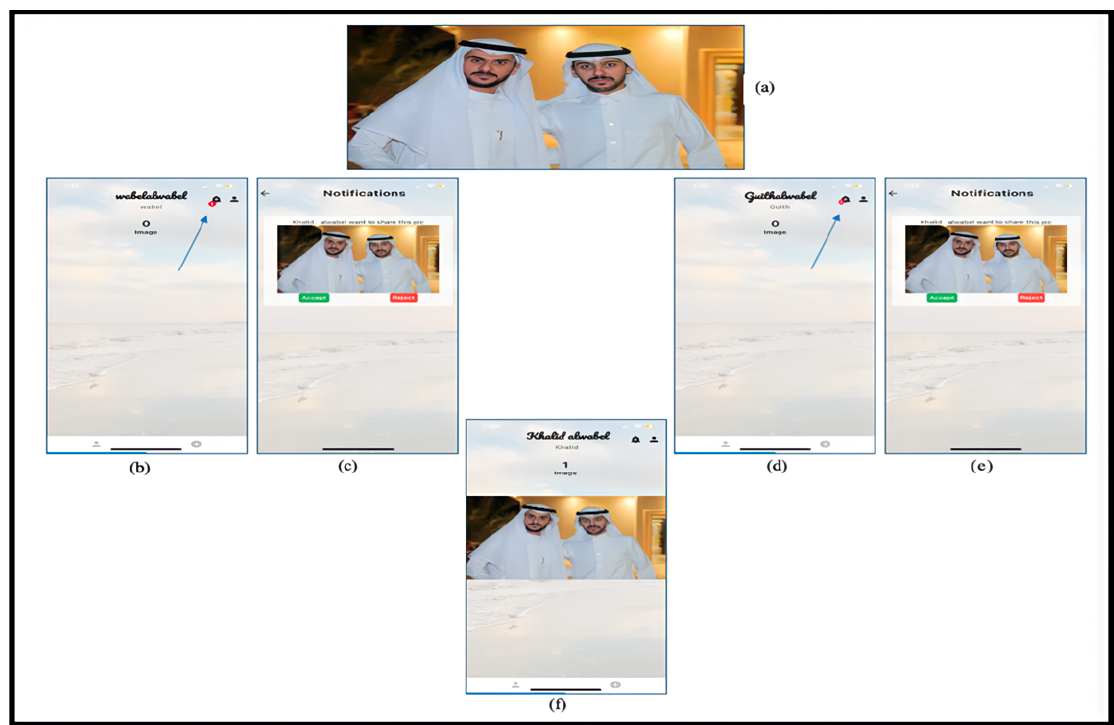
Figure 7 . Post image and notifications in our app: ( a ) represents posting photos, ( b , d ) represent receiving a notification, ( c , e ) represent Image and publisher name with two buttons for acceptance and rejection, and ( f ) represents the image appears on the publisher page after accept.